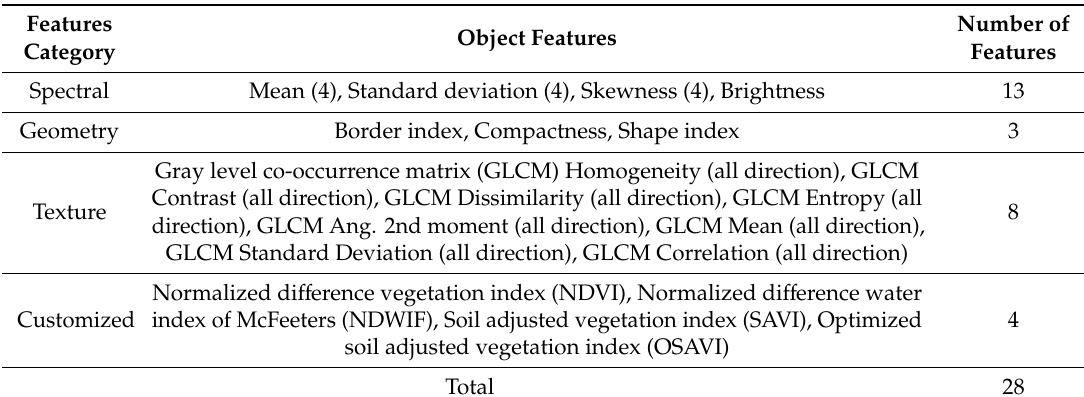
Table 1. Features that were calculated to identify image objects in this study.